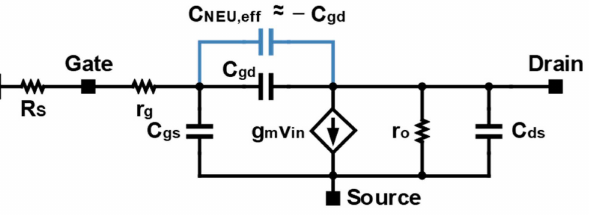
Figure 3. Equivalent half-circuit of the differential common-source structure with the neutralization capacitor.